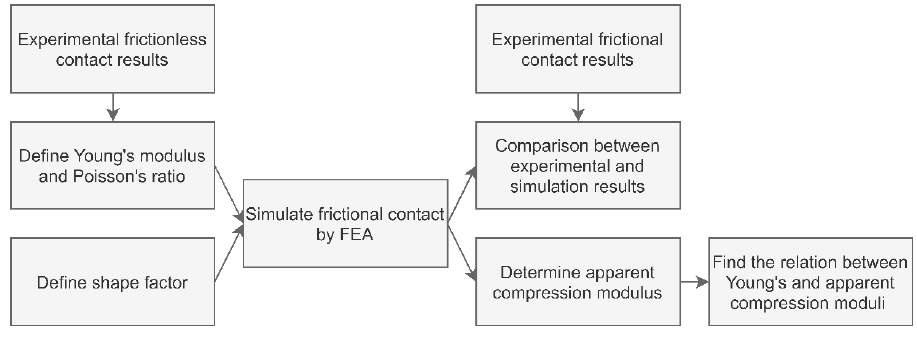
Figure 2. Methodology scheme.